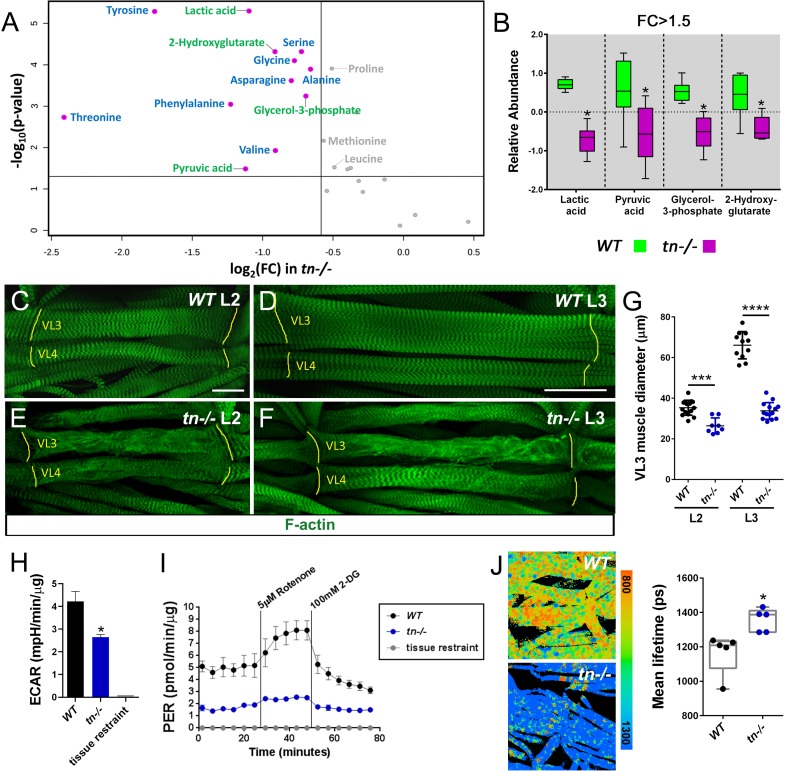
Loss of TRIM32 decreases glycolytic flux and reduces muscle tissue size.(A) Volcano plot illustrating fold change (FC) (log base 2) compared with p-value (- log base 10) between WT and tn-/- L3 larvae. Vertical line represents FC >1.5. Horizontal line depicts a significance level p<0.05. Metabolites that are reduced in tn-/- larvae include indicators of glycolytic flux (green) and amino acids (blue). Metabolites in gray are significant, but exhibit a FC <1.5. (B) Box and whisker plot of terminal glycolytic metabolites significantly reduced upon loss of TRIM32. N = 6. (C–F) Ventral longitudinal muscles 3 (VL3) and 4 (VL4) stained with phalloidin to visualize F-actin (green). (C,D) The stereotypical morphology of WT muscles is not altered as overall muscle size increases from the L2 (C) to the L3 (D) stage. (E,F) In addition to sarcomeric disorganization, the VL3 and VL4 muscles are noticeably smaller in tn-/- larvae during L2 (E) and L3 (F) development. Muscle attachment sites (MASs) are denoted by yellow lines. (G) Scatter plot depicting VL3 muscle diameter. The diameter of WT muscles increase from the L2 to the L3 stage. This cell size increase is abolished in tn-/-. N ≥ 8. (H) Bar graph shows that ECAR measurements are decreased in isolated tn-/- muscle carcasses compared to WT. N ≥ 4. (I) Analysis of the glycolytic rate in WT or tn-/- muscle tissue after subtraction of mitochondrial-produced acidification. This PER is diminished upon loss of TRIM32. N = 4. (J) NADH lifetime image comparison of WT and tn-/- muscles. Box and whisker plot shows WT muscles have significantly lower NADH lifetime, indicative of higher glycolytic flux, than tn-/-. N = 5. Mean +/- SD. (****, p<0.001; ***, p<0.01; *, p<0.05; n.s., not significant). Scale bars: 25 µm (C,E), 50 µm (D,F).